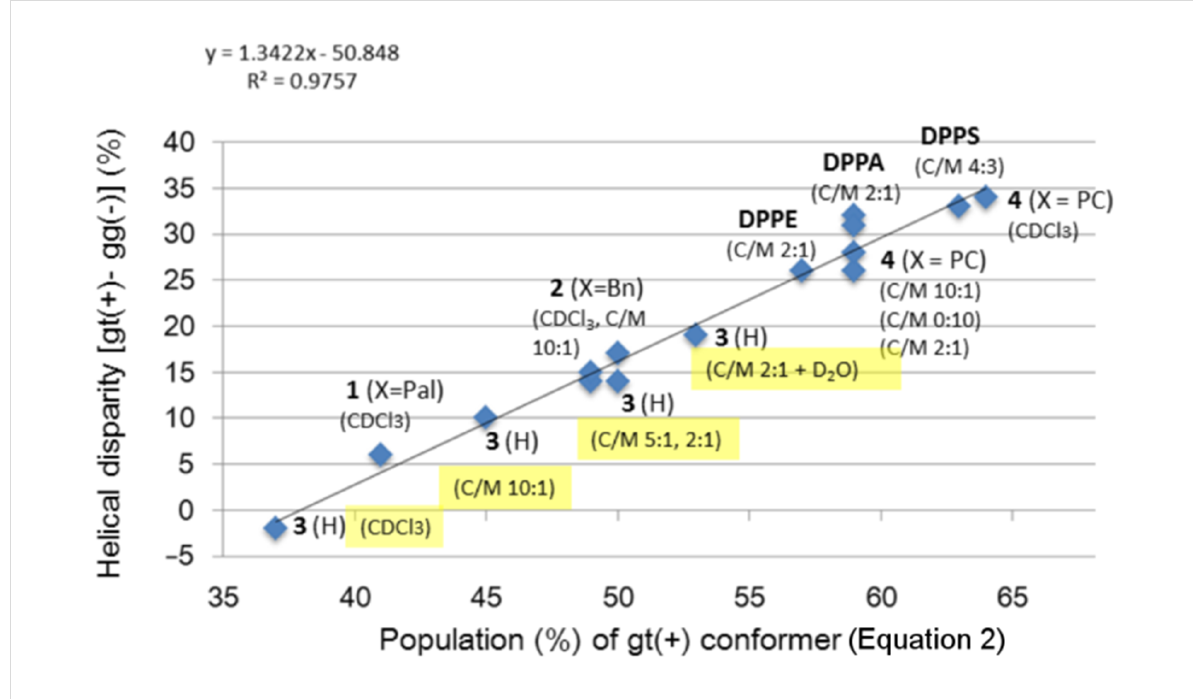
Figure 5: Linear relation between the helical disparity (%) and gt(+) population (%) as observed for the helical conformational properties of 1,2- dipalmitoyl- sn -glycerols 1 – 4 in the solution state.